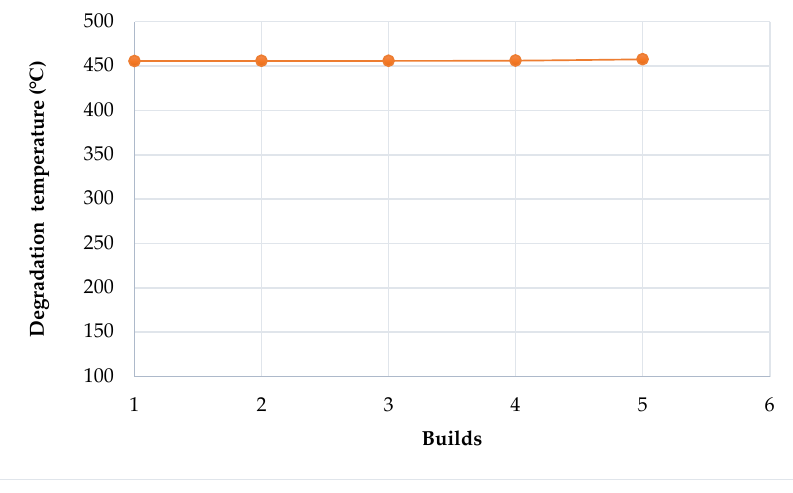
Table 8. TGA results for Laser PP CP 75 after 100% re ‐ use.